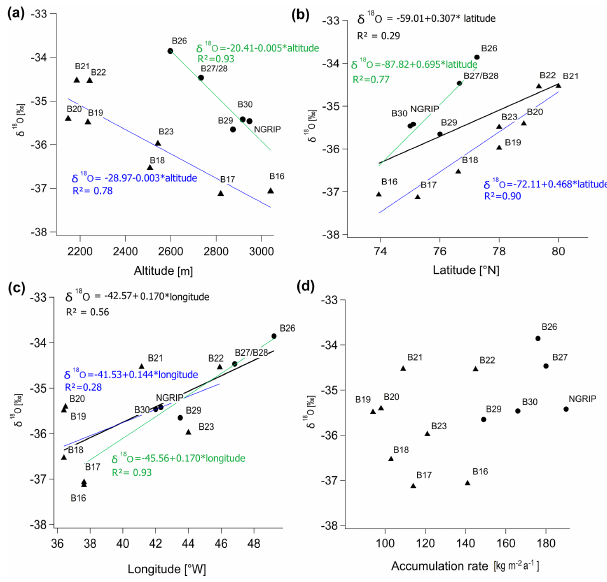
Figure 4. Mean δ 18 O (AD1505–1953) as a function of (a) alti- tude, (b) latitude, (c) longitude and (d) accumulation rate of north- ern Greenland ice core drill sites. Cores with higher accumulation rates (>145kgm − 2 a − 1 ) are given as black dots and lower rates as black triangles, which is similar to the differentiation between east of and on the main ice divide. For statistically significant cor- relations the lines give the linear regression functions (black: mean; green: higher accumulation rates; blue: lower accumulation